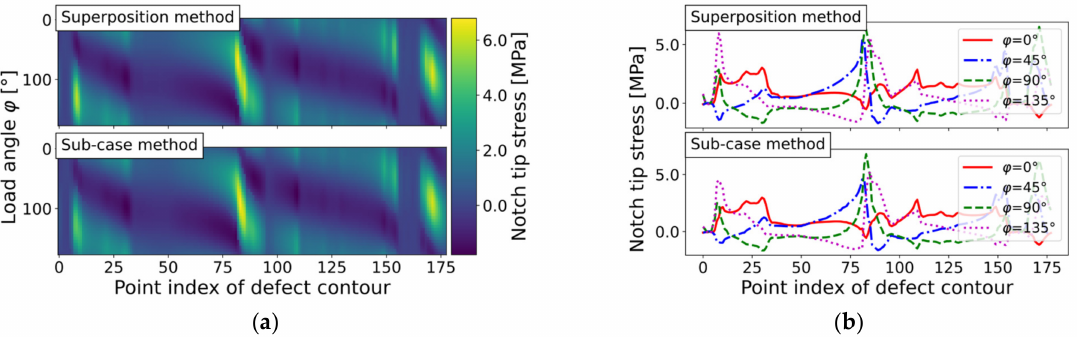
Figure 14. Notch tip stress evaluation of elliptical hole-in-plate (mesh ‘defect_elongated_lin_v1’) by sub-case and superposition methods for incremental load step of ∆ ϕ = 5 ◦ : ( a ) Level plots; and ( b ) Course along defect